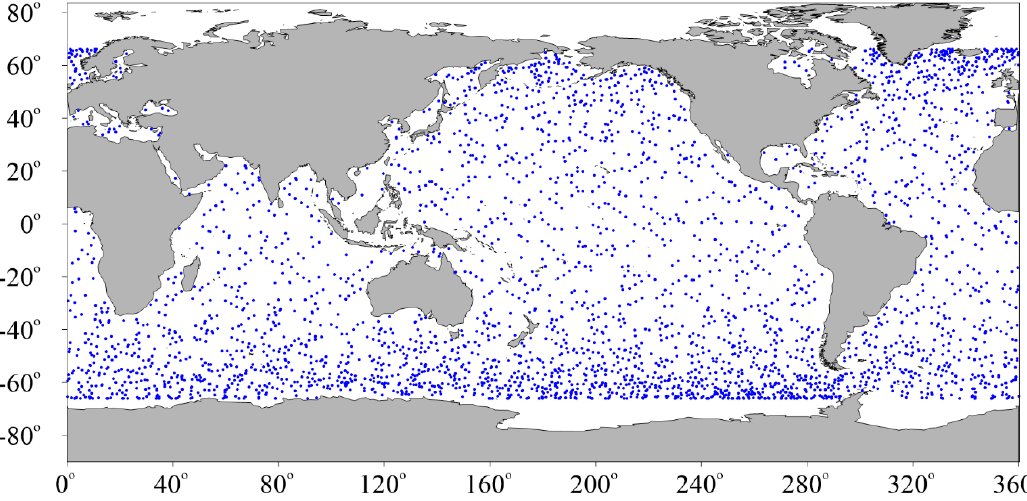
Figure 15. Spatial distribution of dual-crossovers of Sentinel-3A and Jason-3.